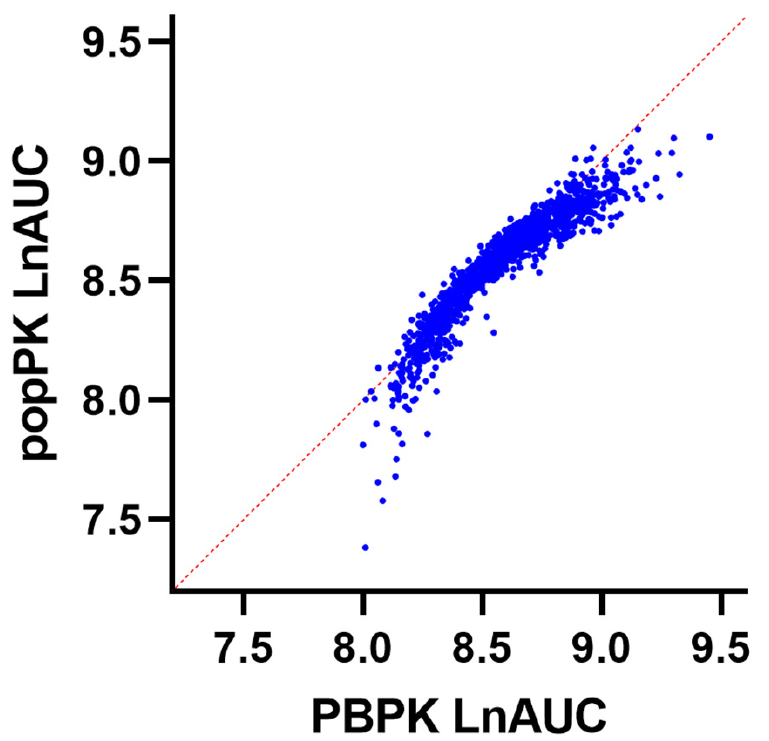
Figure 4. Multivariate linear regression analysis showing the correlated relationship between the simulated popPK natural log-transformed AUC (LnAUC) and simulated PBPK LnAUC. Table 4. Multivariate linear regression analysis of the model-predicted variables affecting epirubicin LnAUC and their respective linearity regarding LnAUC. R 2 of the model is